Question: What form of chart is displayed?
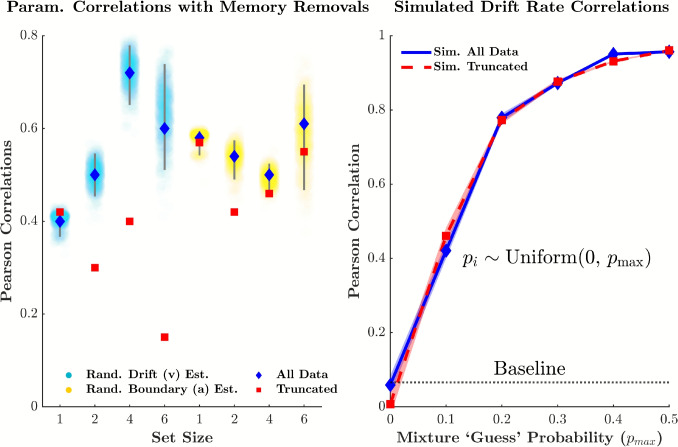
Answer: scatter